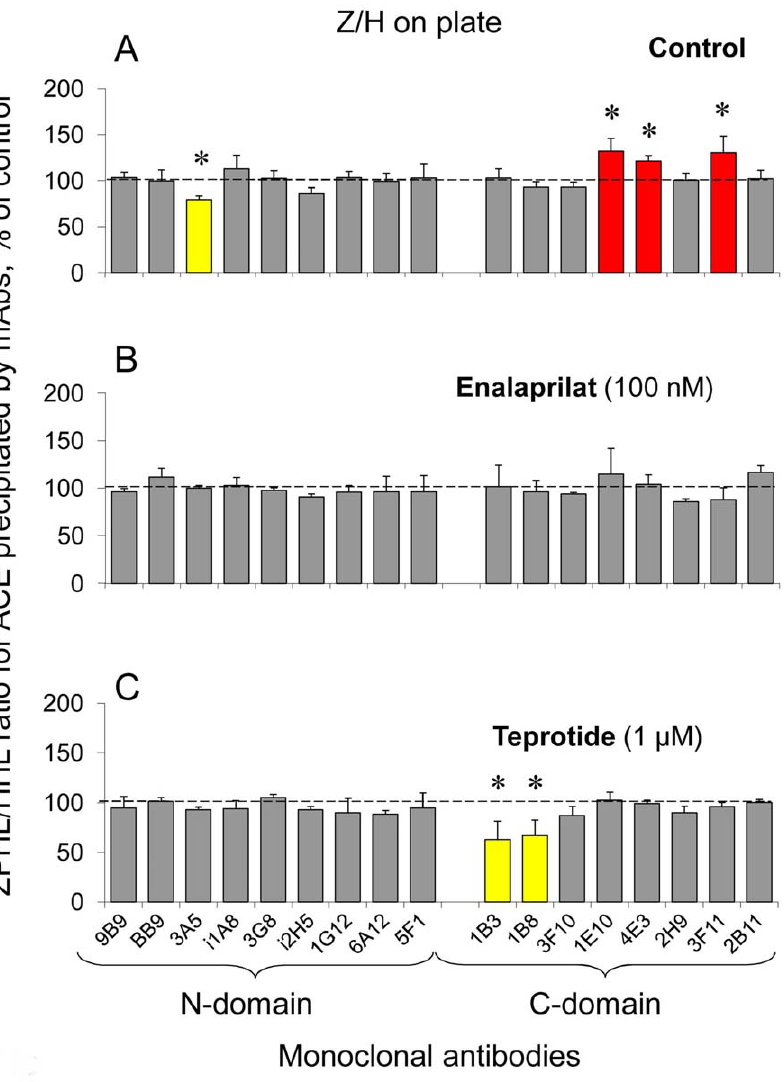
Figure 2. Effect of ACE inhibitors on the comparative rates of ZPHL and HHL hydrolysis by blood ACE bound by mAbs on the plate. A . ACE activity precipitated from citrated pooled plasma by each given mAb was determined spectrofluorometrically directly in the wells (as in Fig. 1) with two substrates for ACE, HHL and ZPHL. Data are expressed as the ratio of the rates of the hydrolysis of two substrates (ZPHL/HHL ratio) by ACE bound by mAbs in comparison with the mean value obtained for all 17 mAbs. * - p , 0.05 in comparison with mean value for the whole set of mAbs. B–C . Effect of enalaprilat (100 nM – B ) and teprotide (1 m M – C ) on ZPHL/HHL ratio determined for ACE bound with each mAb. * - p , 0.05 in comparison with mean values for samples without ACE inhibitors. All other terms and conditions are as in Fig. 1. Red colored columns show those mAbs which binding with ACE increased (and yellow – decreased) ZPHL/HHL ratio. Data are mean 6 SD from 3–8 independent experiments (each in duplicates). p , 0.05 in comparison with mean values for samples without ACE